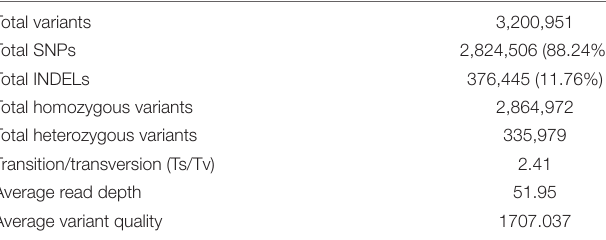
TABLE 2 | Summary statistics of various identified